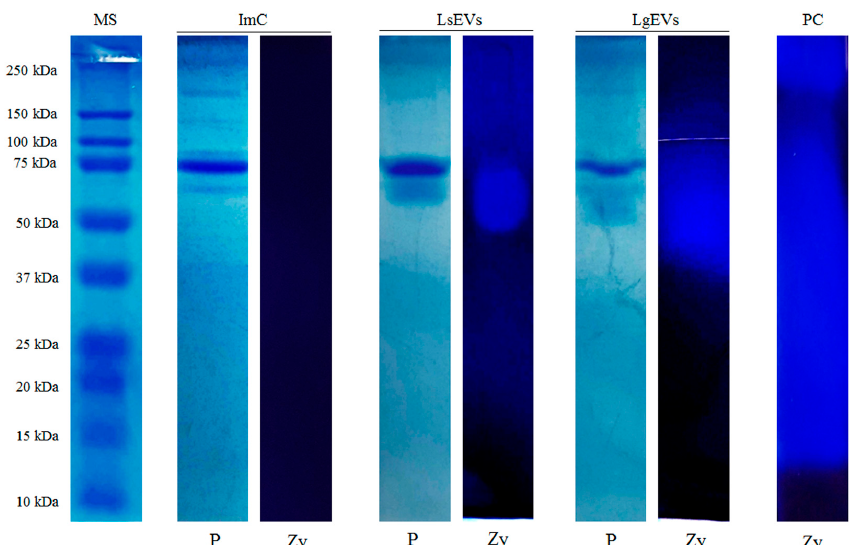
Figure 4. Protein constitution and proteolytic activity of EVs from L. shawi and L. guyanensis. EVs were evaluated by SDS-PAGE (P) and by zymography (Zy), and images of the strips were acquired. MS: molecular weight size marker. ImC: isolation method control (Supplemented Schneider’s medium extracted with exosome isolation reagent); LsEVs—EVs from L. shawi promastigotes; LgEVs: EVs from L. guyanensis promastigotes; PC: positive control of proteolytic activity (1 ×